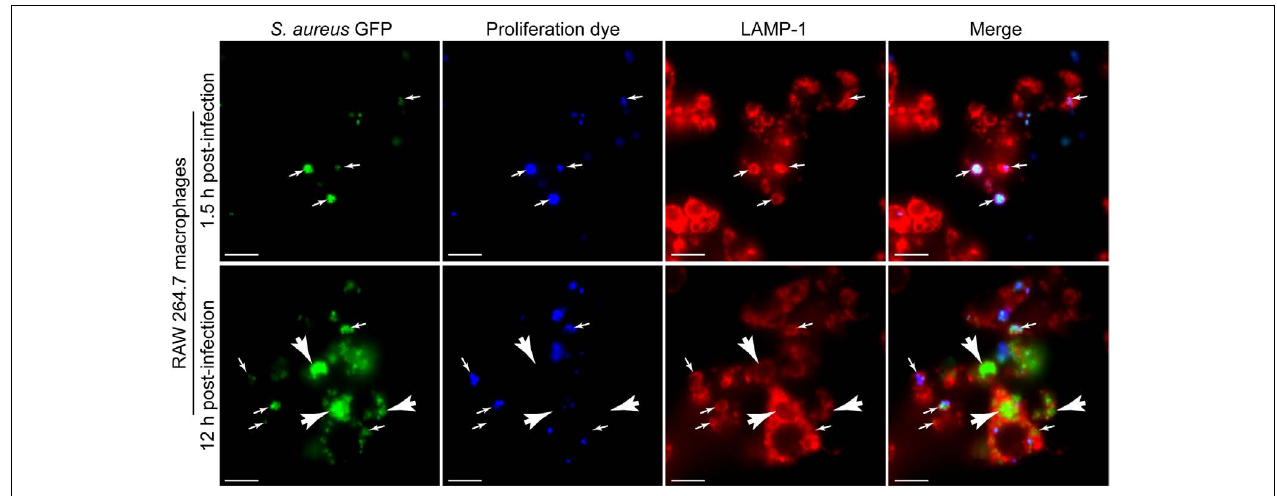
FIGURE 5 | Fluorescence proliferation dye can be used to identify bacteria replicating in lysosome associated membrane protein-1 (LAMP-1) positive compartments. The representative images depict RAW 264.7 macrophages infected with GFP-expressing S. aureus USA300 (in green) co-labeled with eFluor TM -670 (in blue) that are also immune-stained for endogenous LAMP-1 protein (in red). Images are of cells at 1.5 and 12 h post-infection and are representative of data normally obtained from greater than ten independent experiments. Small white arrows point to GFP-positive cocci that are eFluor TM -670 positive and that are demarcated by LAMP-1 fluorescence. White arrow heads point to GFP-positive yet proliferation dye negative S. aureus that are LAMP-1 positive. Scale bar equals 10 µ m. Note: The image series shown for the 12 h time point is presented elsewhere in an alternate form (Copyright © American Society for Microbiology; Flannagan et al.,